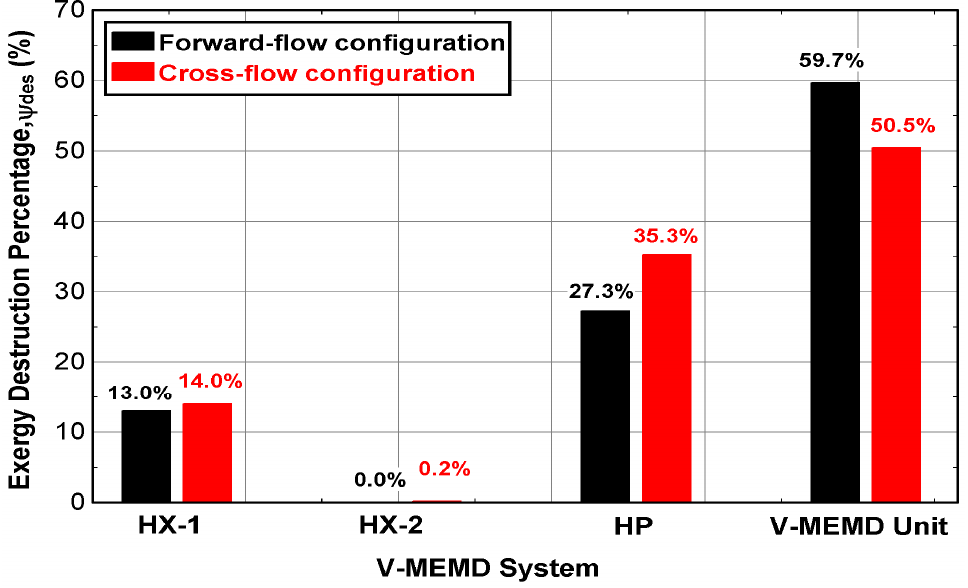
Figure 13. Exergy destruction percentage of the main components of the V-MEMD system ( v H 1 = 900 L/h, T H 1 = 75 ◦ C, v C 1 = 405 L/h, T C 1 = 20 ◦ C, v F 3 = 159 L/h, C F 3 = 1260 ppm, and P v = 11.5